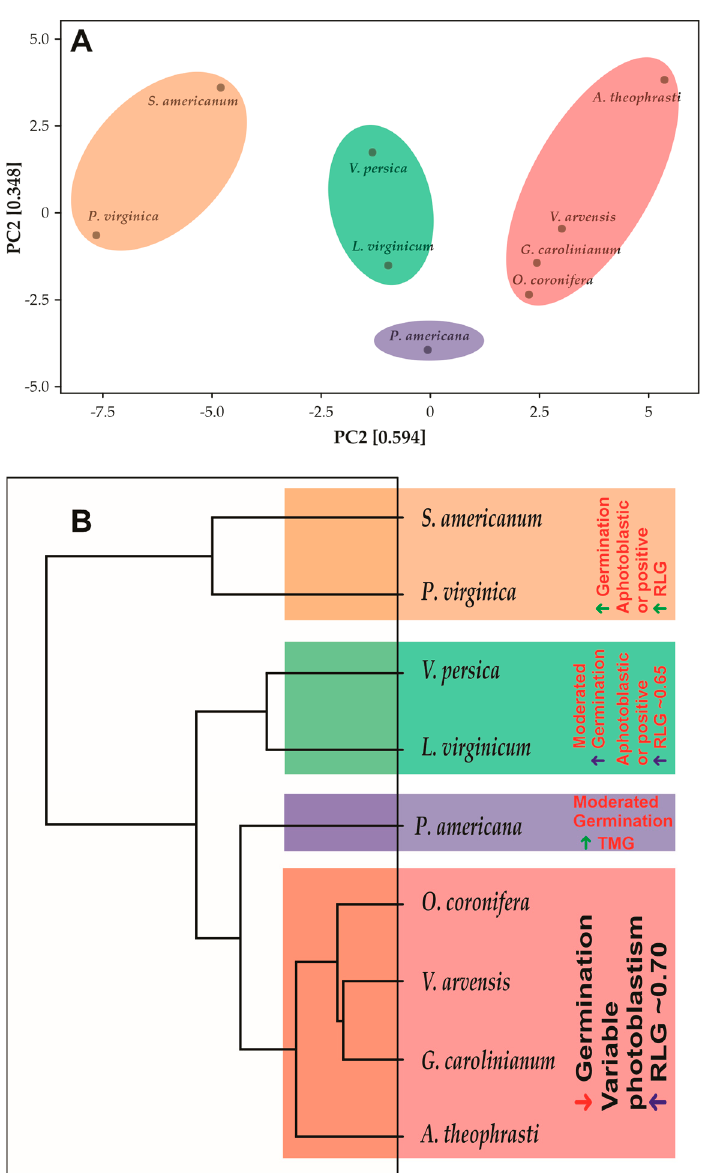
Figure 3. ( A ). Principal component analysis showing the 4 distinct groups in a cartesian plan (PC1 and PC2). ( B ). Dendrogram showing the diversity of species, showing branches less differentiated (top of figure) and highly differentiated branched (on the base).